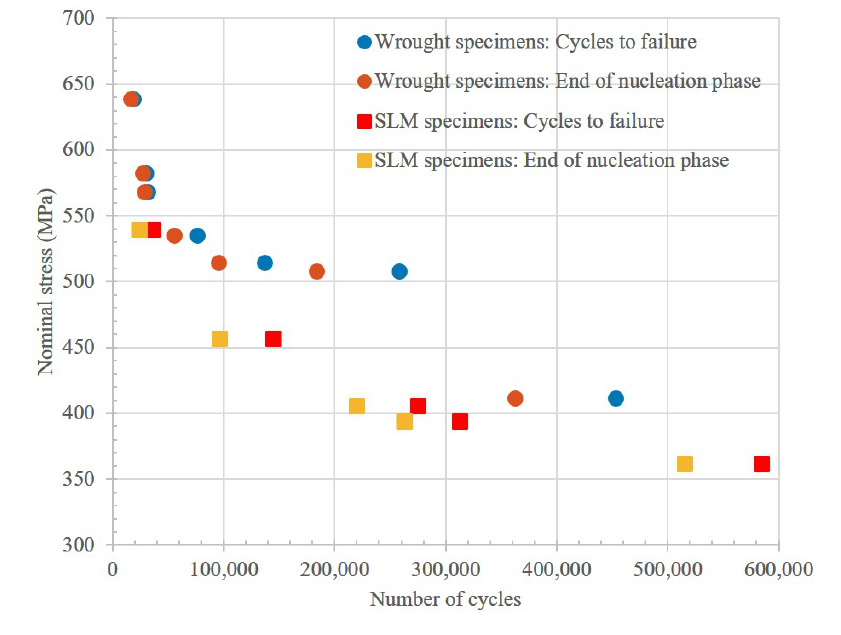
Figure 13. End of nucleation phase and cycles to failure for fine finished wrought and SLM fabricated specimens.